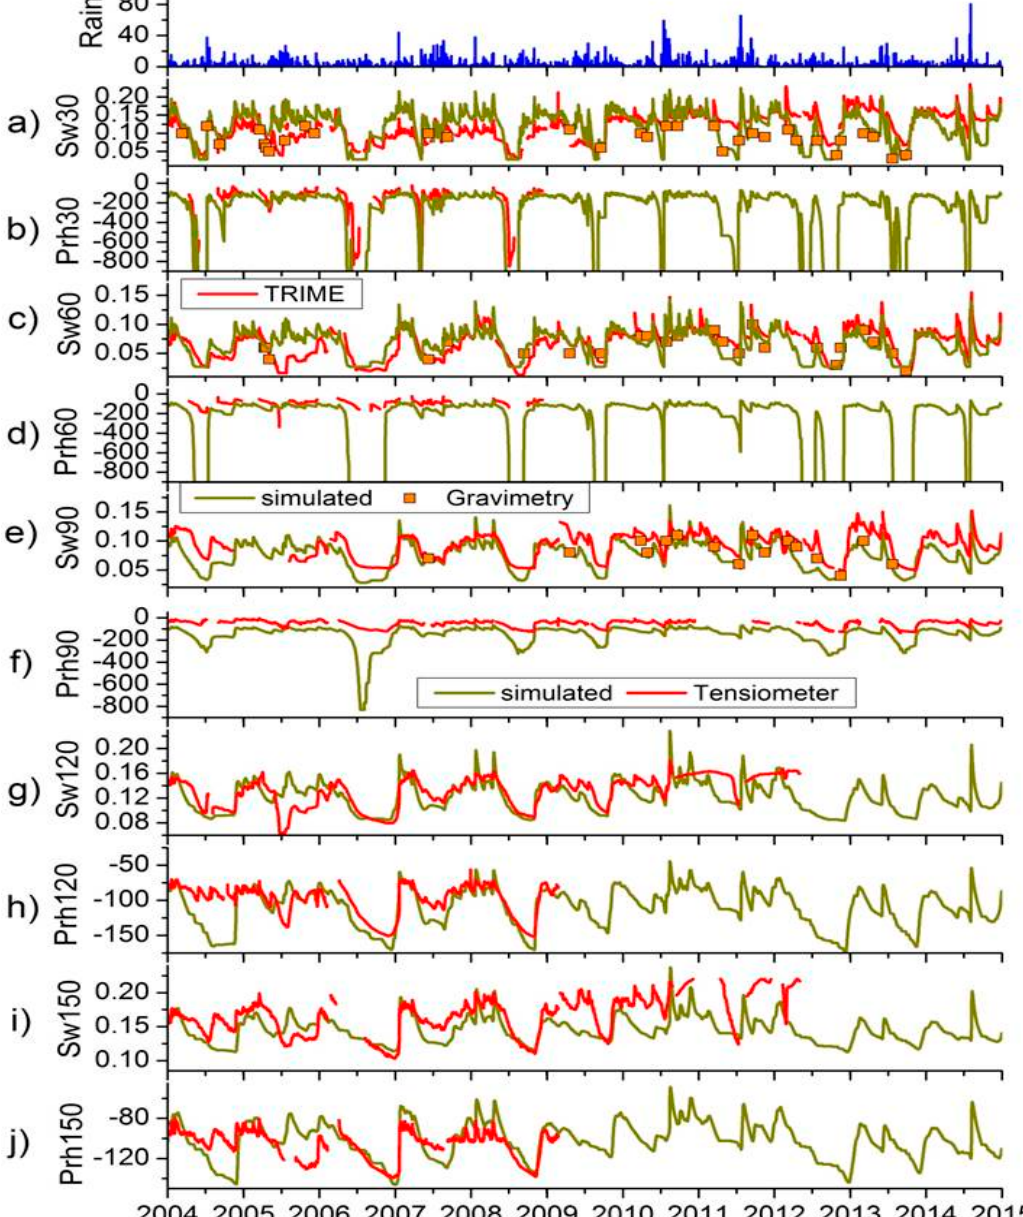
Figure 10. Daily rainfall (Rain) in mm d − 1 , simulated and measured soil water contents (TRIME, Gravimetry) in cm 3 cm − 3 at soil compartments 0–30 cm ( a , Sw30), 30–60 cm ( c , Sw60), 60–90 cm ( e , Sw90), 90–120 cm ( g , Sw120), and 120–150 cm depth ( i , Sw150) and pressure heads in hPa